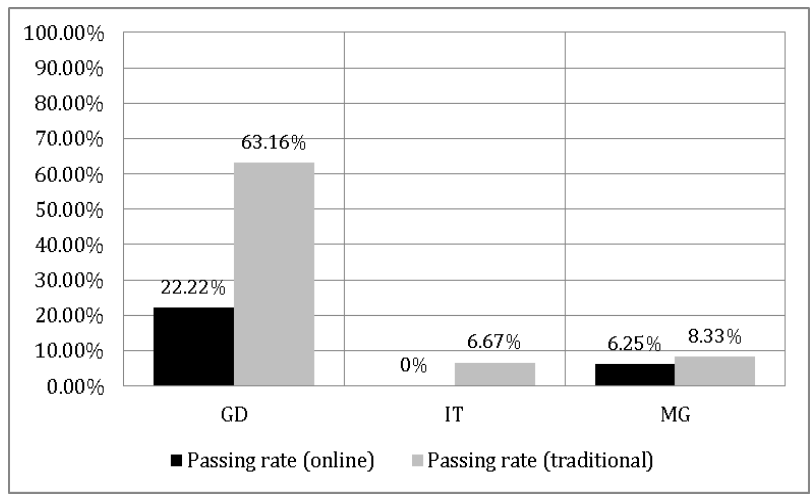
Figure 5 . Percentage of students who passed the course for GD, IT, and MG for students who did not use learning